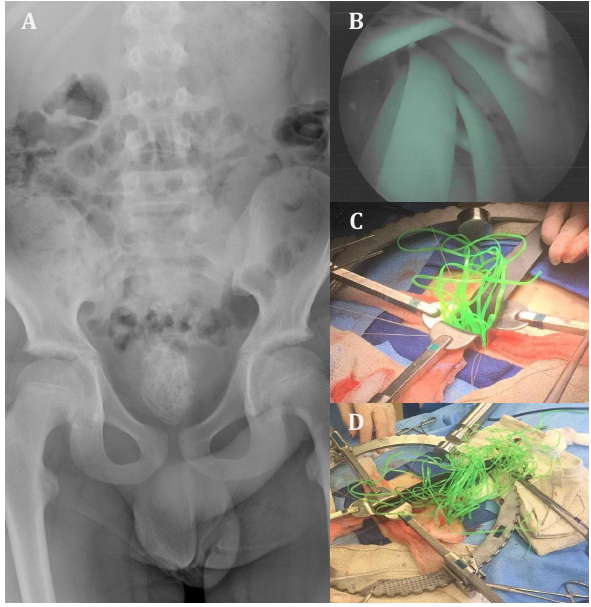
Figure 1. A - abdominal X-Ray with hyperdense foreign body visible in the bladder; B - endoscopic view of coiled foreign body within the bladder; C - open surgical removal of foreign body, mid-extraction; D - open surgical removal of foreign body, post-extraction.